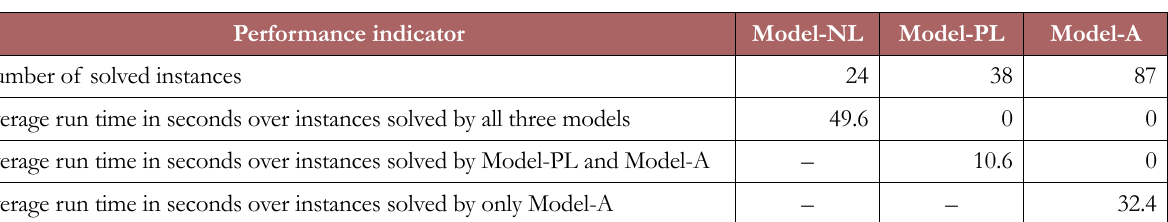
Table 2. Comparison of Model-NL, Model-PL, and Model-A